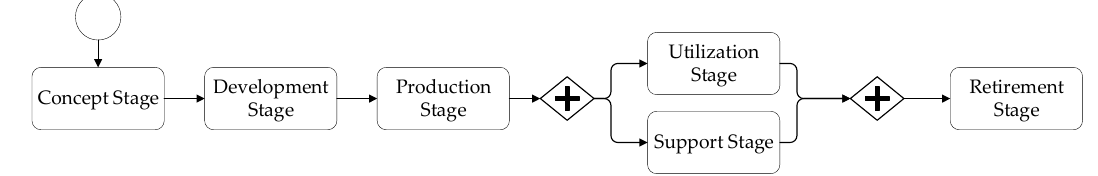
Figure 1. ISO / IEC 15288 System Lifecycle with the key lifecycle stages Figure 1. ISO/IEC 15288 System Lifecycle with the key lifecycle stages [9]